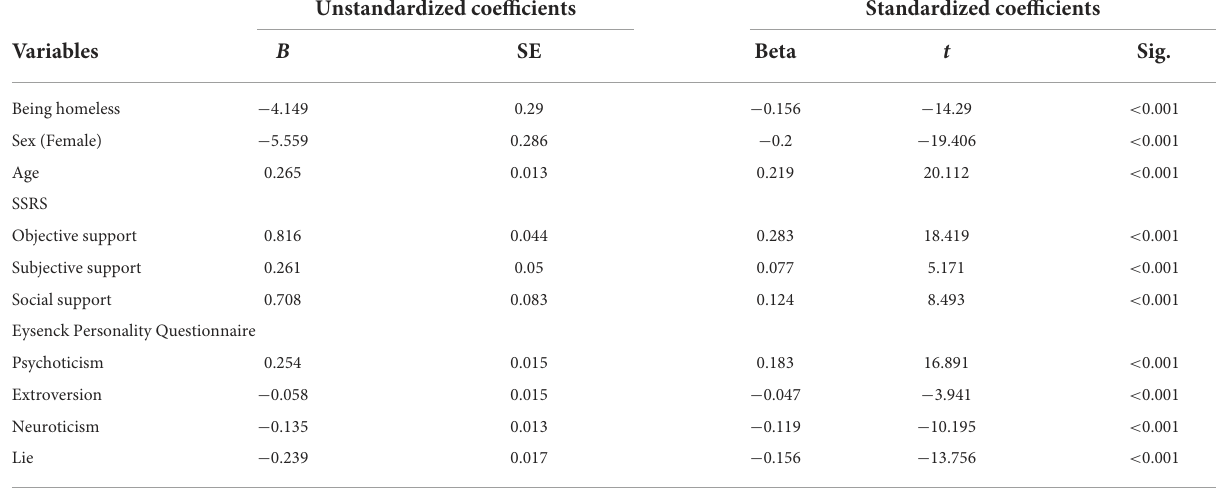
TABLE 4 Multivariate analysis for variables associated with